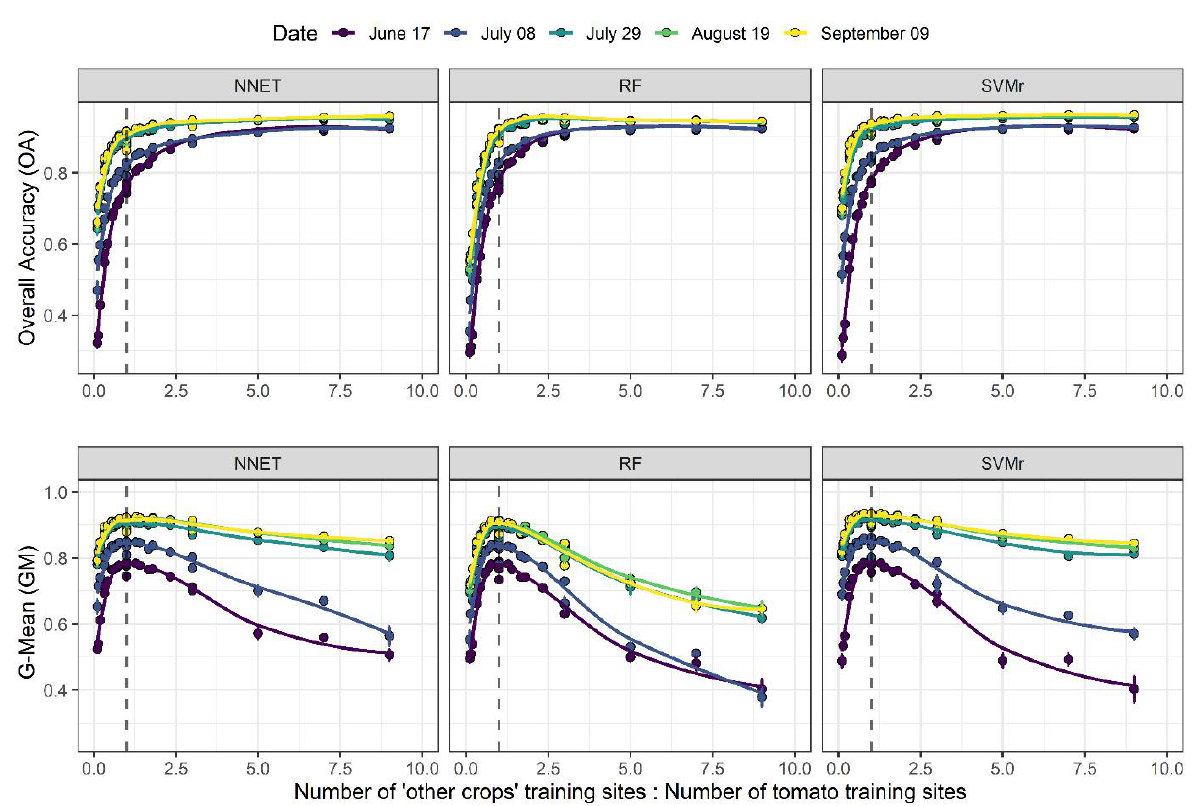
Figure 5. Overall Accuracy and G-Mean progress over the ratio between the number of ‘other crops’ training sites and the number of tomato training sites at different lead time. The dotted line represents the 1:1 ratio.